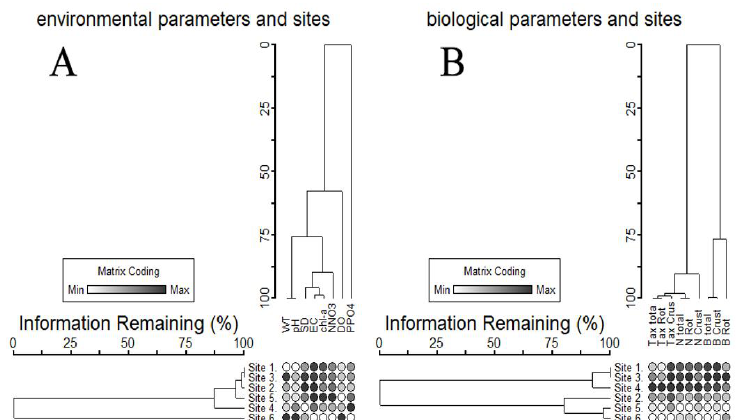
Figure 7. Tree diagrams of cluster analysis of study sites based on environmental parameters ( A ) and biological parameters ( B ) (zooplankton data) obtained using Ward’s method as linkage rule and and biological parameters ( B ) (zooplankton data) obtained usin g Ward’s method as linkage rule and Euclidean distances as the metric for distance calculation. Euclidean distances as the metric for distance